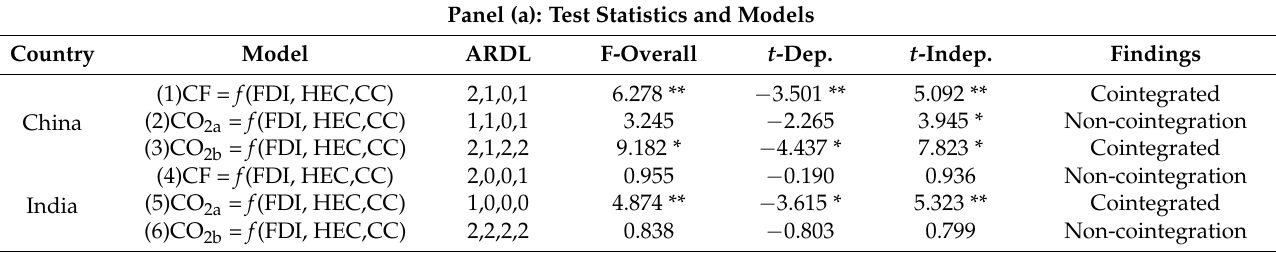
Table 5. Cointegration analysis